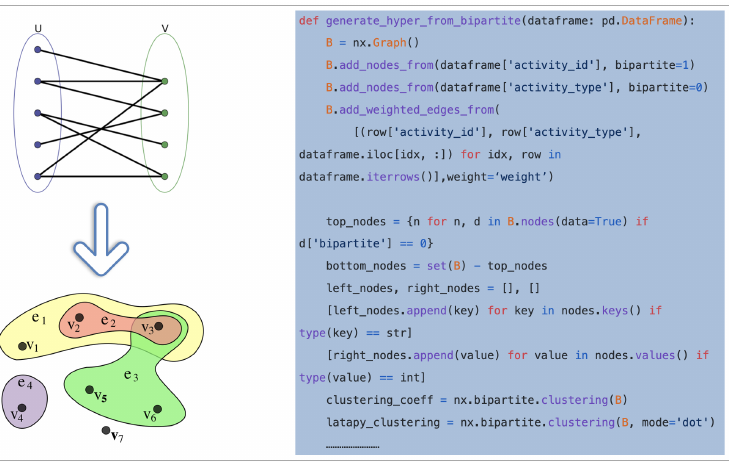
Figure 13. From bipartite graph to hypergraph.